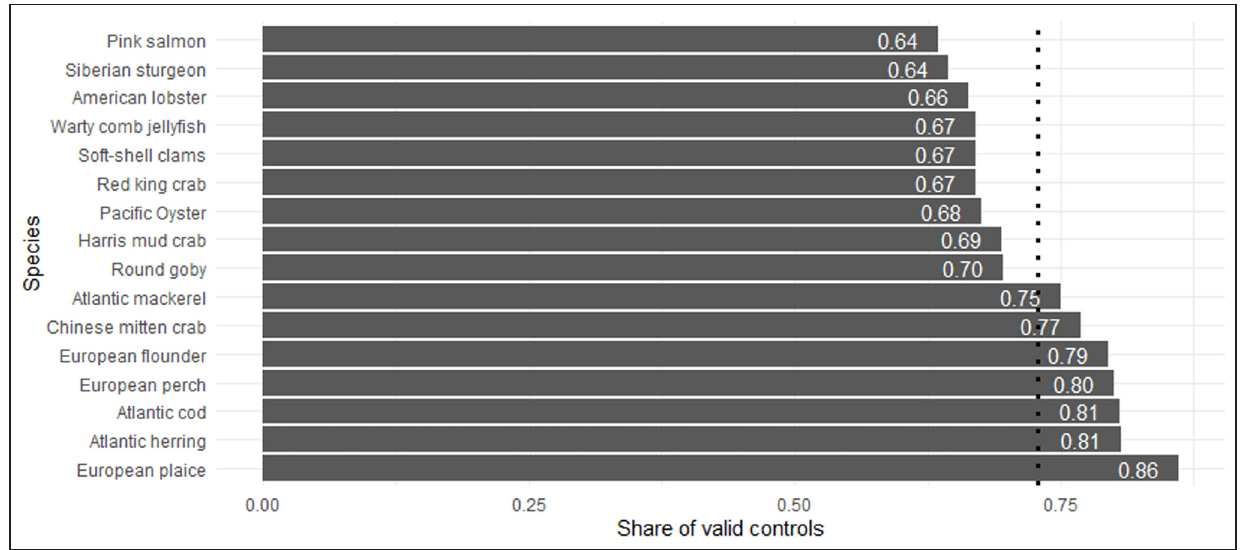
Figure 5 Share of valid controls conducted by citizens per species assay. The average success rate across species, 0.72, is marked by the dotted